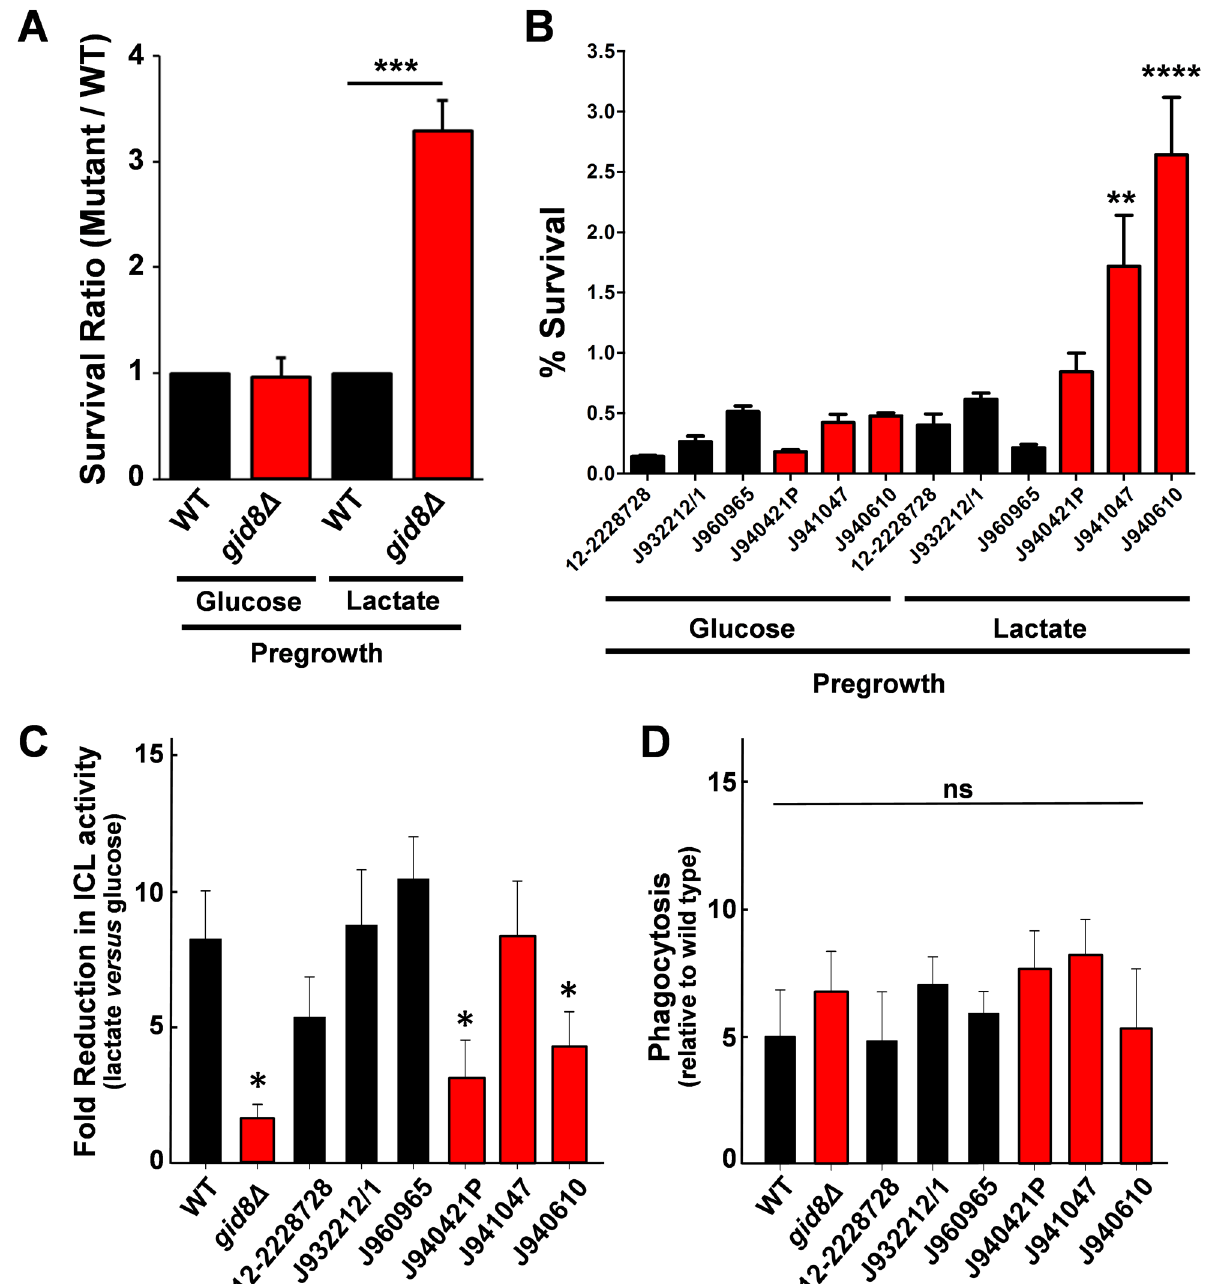
Fig 9. Crabtree negative S . cerevisiae strains are more resistant to macrophage killing. (A) S . cerevisiae wild-type (black bars, S288c) and gid8 Δ cells (red, DCY122) were pre-grown in YNB-glucose or YNB-lactate, and then co-incubated with J774.1 macrophages. The viability of the gid8 Δ cells after 48 hours is expressed relative to the corresponding wild type control. (B) Using the same approach, the resistance of three Crabtree positive S . cerevisiae clinical isolates (black) and three Crabtree negative clinical isolates (red) to macrophage killing was compared. (C) Isocitrate lyase activities were measured in the same S . cerevisiae strains after pre-growth overnight in YNB-lactate followed by growth in YNB-glucose or YNB-lactate for 2 h. The fold-reduction in Icl1 activity in cells exposed to glucose is expressed relative to the control cells grown in lactate. Statistical significance was calculated relative to the fold- reduction observed in the wild type control (S288c). (D) The phagocytic uptake of the S . cerevisiae strains was determined after pre-growth in YNB-lactate, and then co-incubation with J774.1 macrophages for 2 h. No significant differences (ns) were observed relative to the wild type control. The data represent two independent biological experiments performed in technical triplicate ± SEM. They were analysed relative to the glucose grown controls by two-way ANOVA with multiple comparisons test: * , P (cid:1) 0.05; ** , P (cid:1) 0.01; *** , P (cid:1) 0.001; **** , P (cid:1)